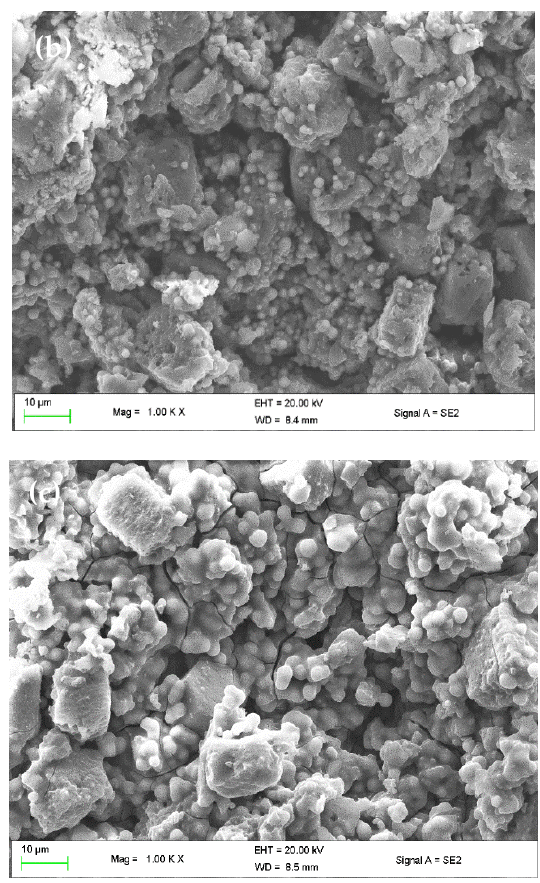
Figure 3. SEM images of samples ( a ) S1, ( b ) S2, and ( c ) S3.